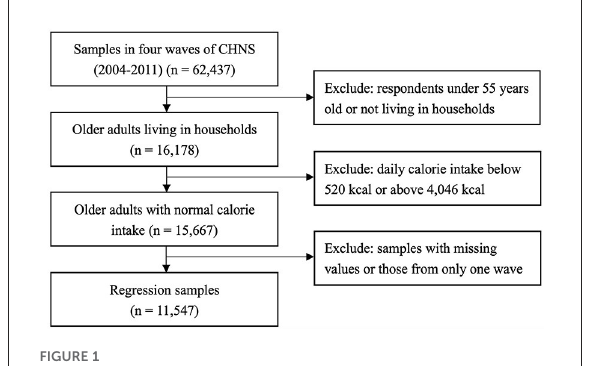
FIGURE1 Flow chart of study population selection.